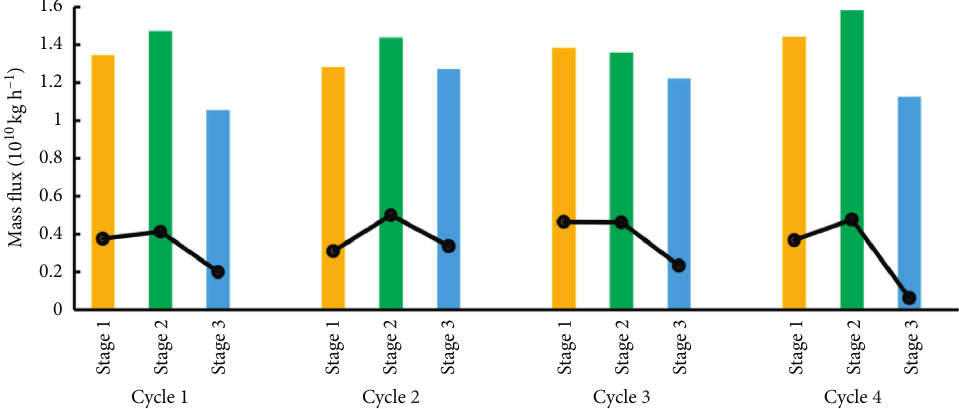
Figure 11: Total mass fluxes at the height of 12.7km in the eyewall (bars) and the mass fluxes as a result of w > 7.4m s − 1 (lines) for each of the three stages of the four